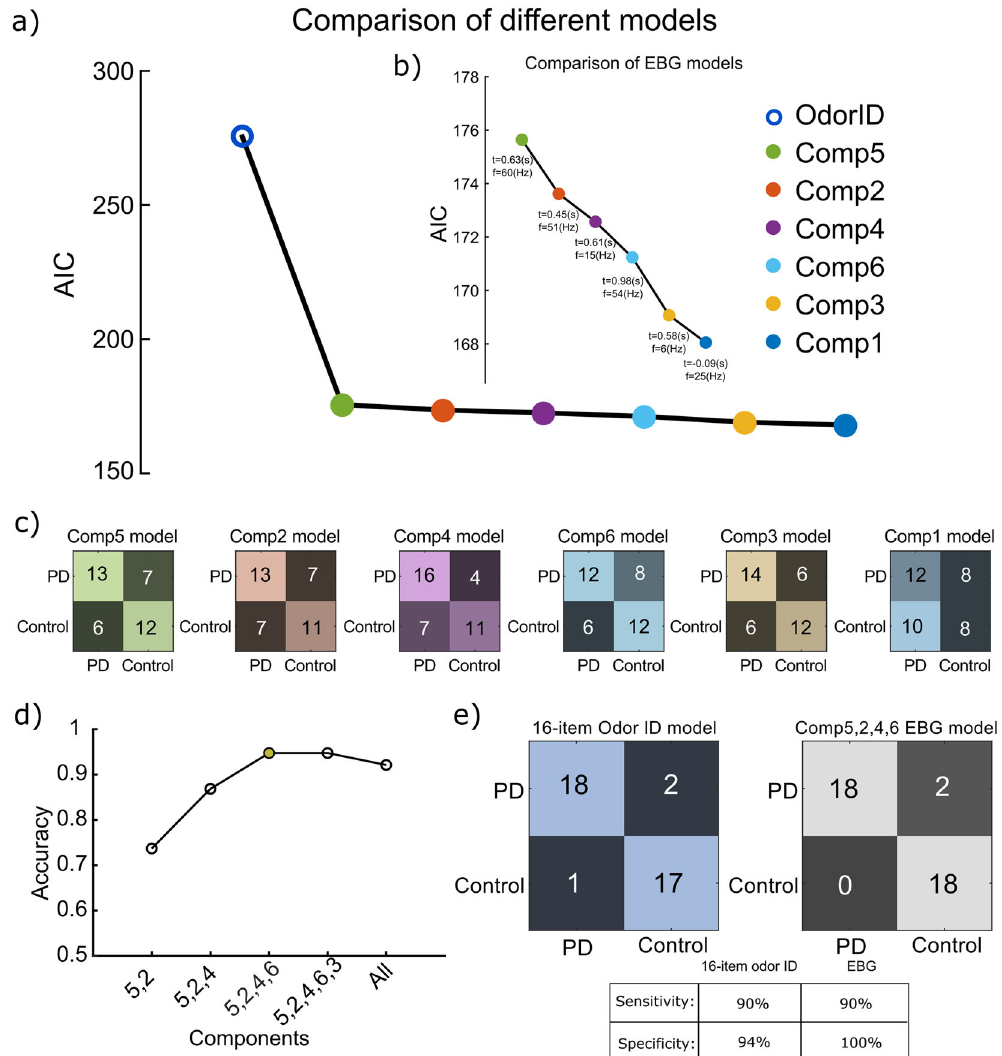
Fig. 2 Comparison within EBG models as well as EBG and odor identi fi cation models. a Akaike information criteria (AIC) for each EBG component and 16-item odor ID. b Zoomed-in AIC values for the only EBG models. c Cross table of each component of the EBG models shows true/false positive/negative values. The colors of the EBG components in the panel ( a ), ( b ) and ( c ) correspond with Fig. 1g. d Accuracy of models with stepwise adding components shows maximum accuracy for the model includes components 5, 2, 4, and 6. Peak accuracy is marked with a fi lled yellow circle. e Crosstables of 16-item odor ID and multicomponent EBG model show comparable sensitivity and higher speci fi city, yet we found slightly more in-sample error compare with 16-item odor